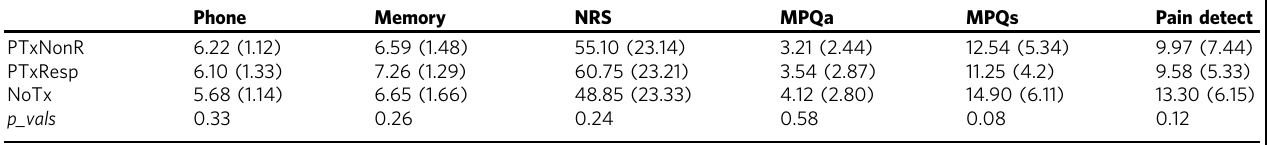
Table 1 Absolute levels of pain prior to treatment showed no group differences on all pain measures